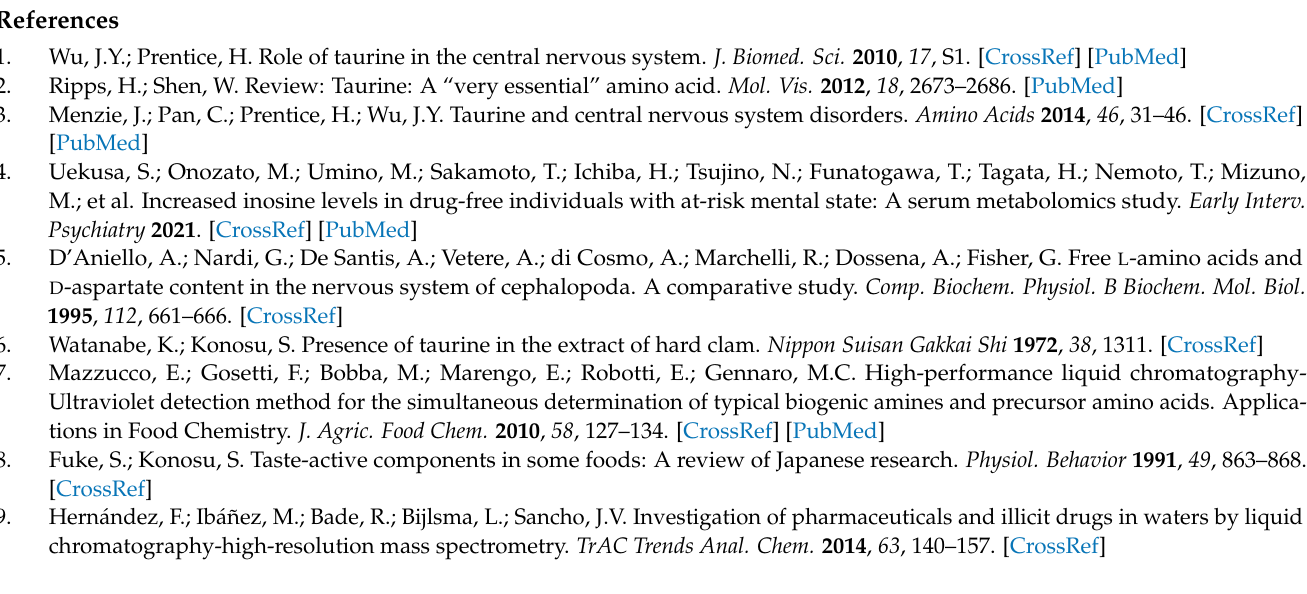
Table S9. Main fragmentation of Arg derivatives (C 31 H 34 N 8 O 11 S, 726.2067) as a function of NCE (ESI ( − ) mode), Table S10. Main fragmentation of Tau derivatives (C 27 H 27 N 5 O 12 S 2 , 677.1097) as a function of NCE (ESI ( − ) mode), Table S11. Precision of Tau/IS ratio, Table S12. Precision of the Val/IS ratio, Table S13. Precision of Gln/IS ratio, Table S14. Precision of Glu/IS ratio, Table S15. Precision of Arg/IS ratio, Table S16. Tau content in bivalve, Table S17. Val content in bivalve, Table S18. Gln content in bivalve, Table S19. Glu content in bivalve, and Table S20. Arg content in